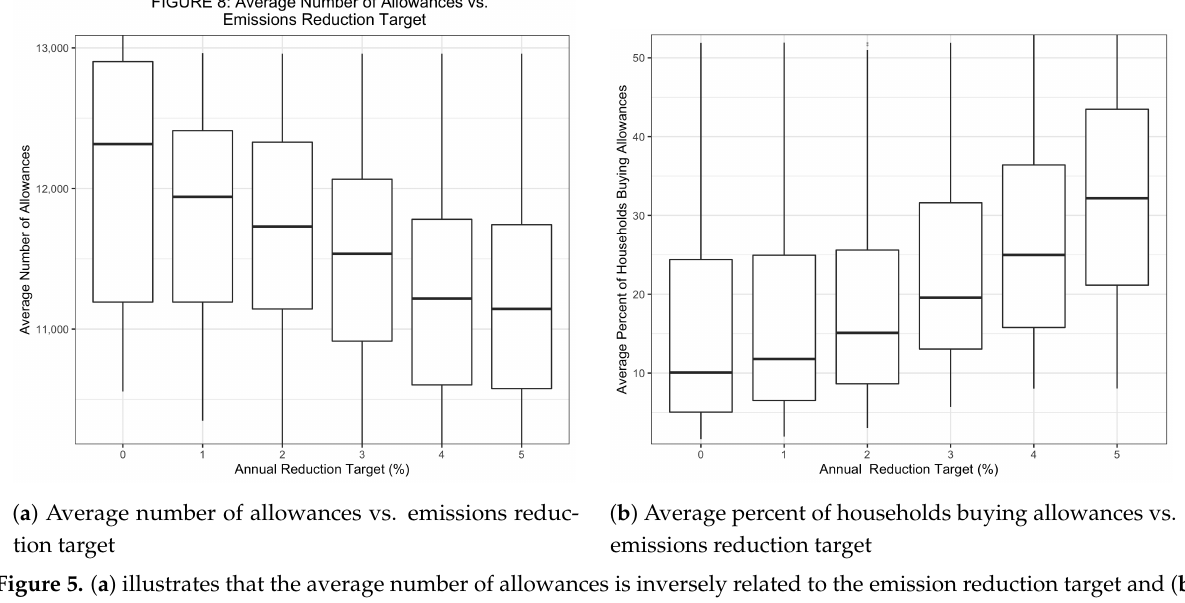
Figure 5. ( a ) illustrates that the average number of allowances is inversely related to the emission reduction target and ( b ) shows that the number of households buying allowances increases with a higher emissions reduction